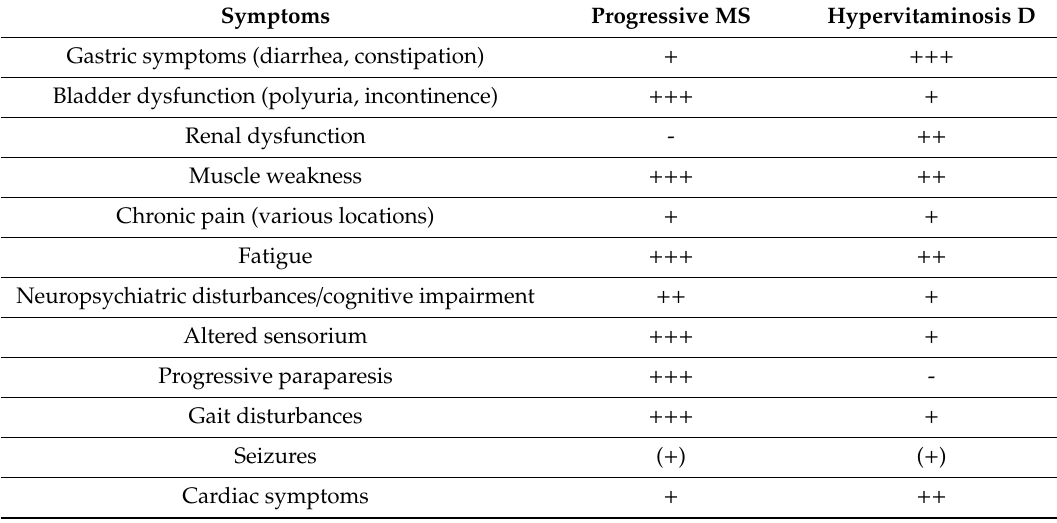
Table 2. Overlap of symptoms of progressive multiple sclerosis and acute or chronic vitamin D intoxication. Symbols: - absent, ( + ) rare, + – +++ common to very common. MS: multiple sclerosis. Symptoms Progressive MS Hypervitaminosis D Gastric symptoms (diarrhea, constipation)